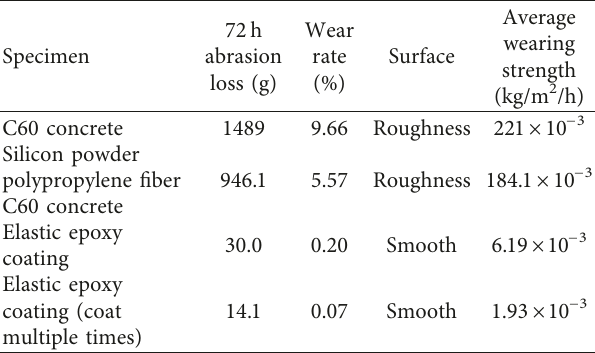
Table 6: Material abrasion-resistance test results